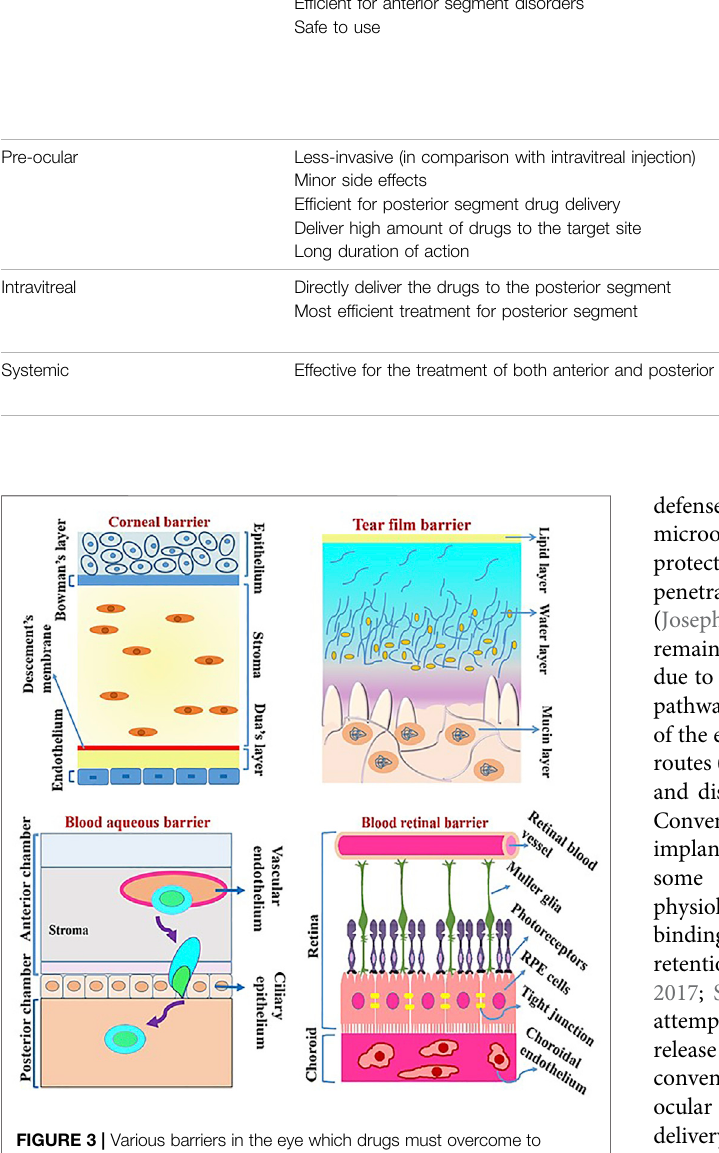
Frontiers in Chemistry |